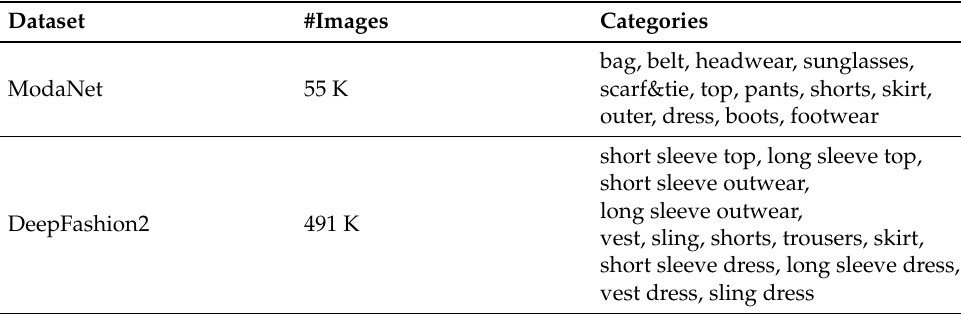
Table 1. Comparisons of ModaNet and